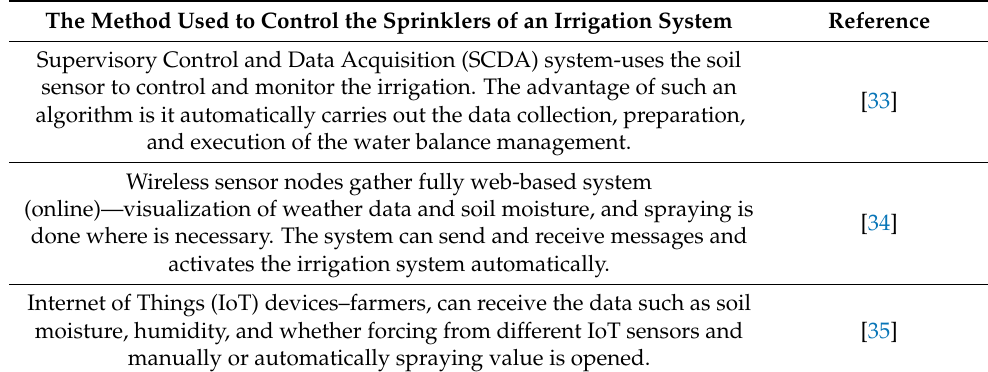
Table 1. Summary of the Literature with different control method in Smart Irrigation. The Method Used to Control the Sprinklers of an Irrigation